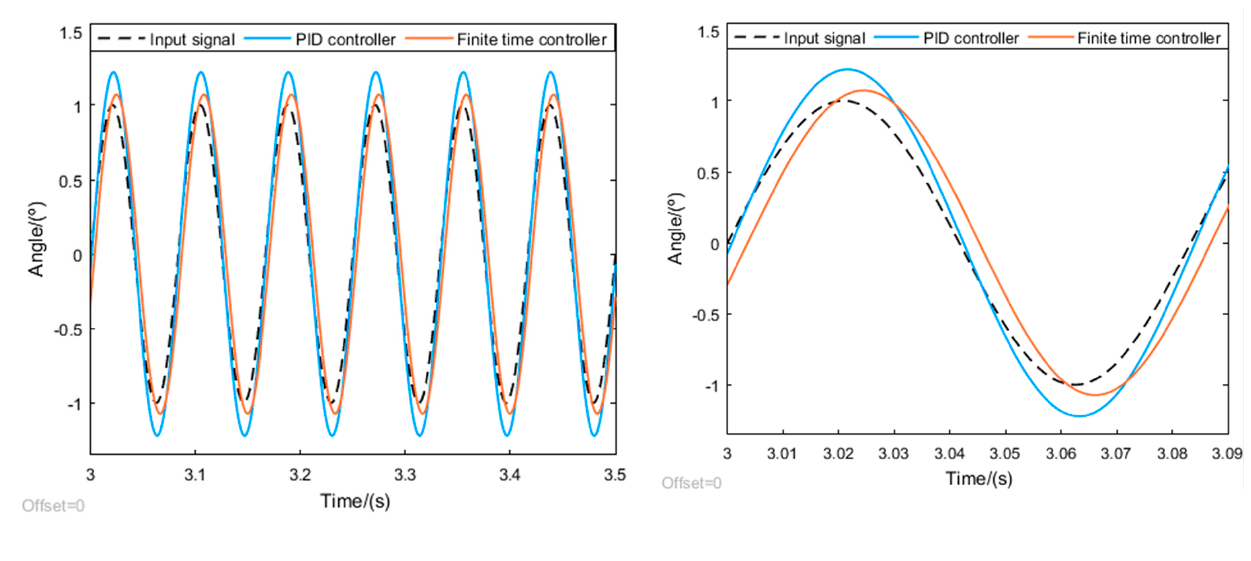
Figure 11. Finite-time composite control response curve of the motor system with 12 Hz and 1° sinusoidal signal.